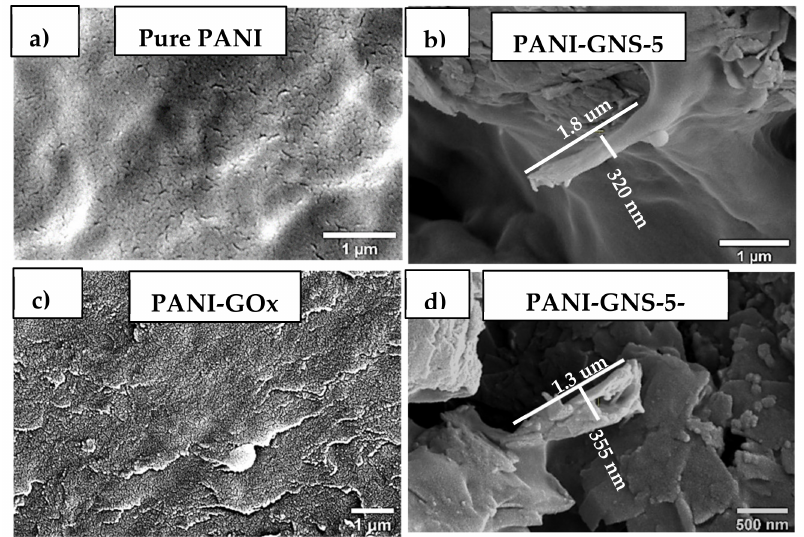
Figure 3. Surface morphology of ( a ) PANI, ( b ) PANI-GNS-5, ( c ) PANI-GOx, and ( d ) PANI-GNS-5-GOx electrodes; single fiber of graphene nanoscrolls from ( b ) PANI-GNS-5 and ( d )